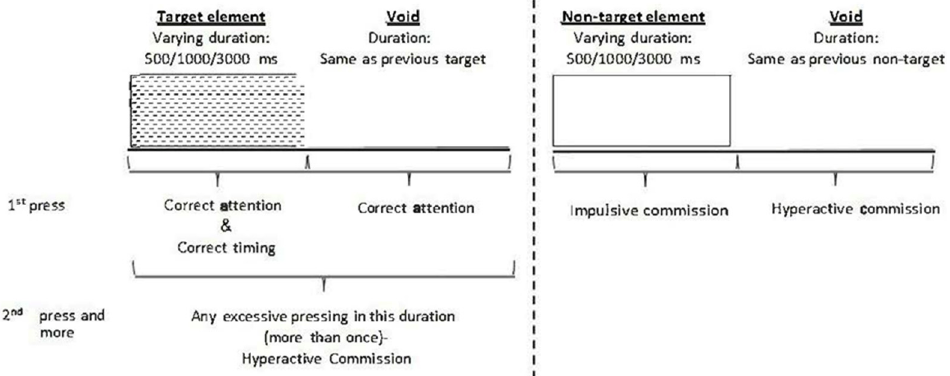
Figure 1. MOXO-CPT description. MOXO-CPT, MOXO continuous performance test; ms, millisec- onds. Definition of the timeline, target, and non-target stimuli were presented for 500, 1000, or 3000 ms. Each stimulus was followed by a void period of the same duration. The stimulus remained on screen for the full duration regardless of the response. Distracting stimuli were not synchronized with target/non-target onset, and could be generated during target/non target stimulus or during the void period.